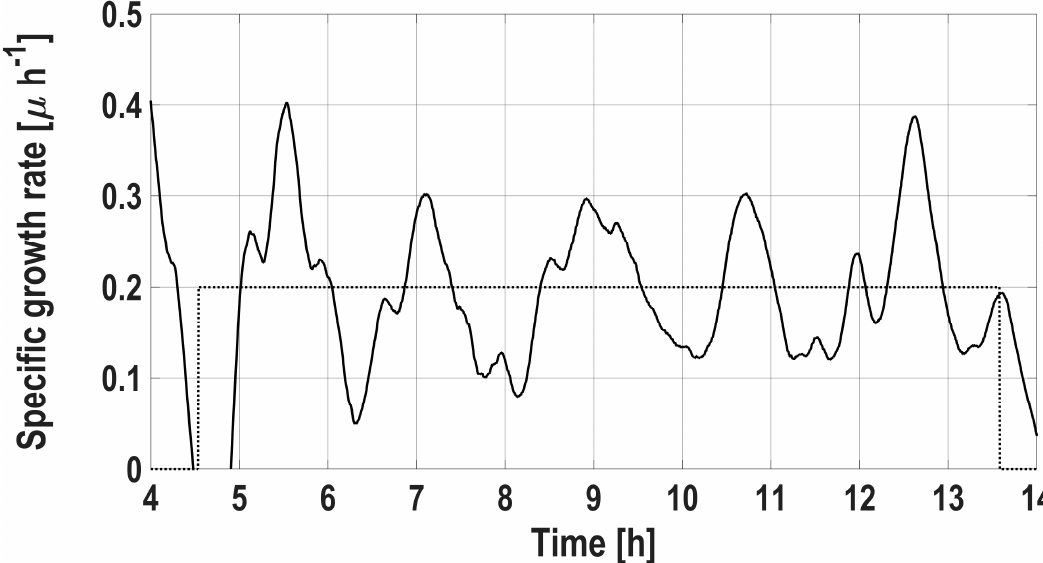
Figure 5. Setpoint (dash line) and estimated specific growth rate (solid line) during a controlled fed-batch culture, controller logic (Equation